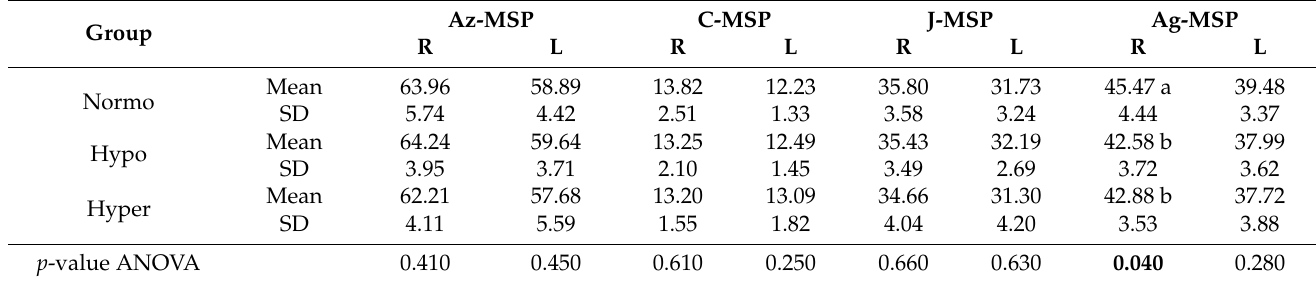
Table 6. Linear asymmetry variables, reported as means (mm) and Standard Deviations (SD) in the three study groups (Normo: Normodivergent; Hypo: Hypodivergent; Hyper: Hyperdivergent). Statistically significant p -values are reported in bold. Different letters indicate statistically significant difference between groups in the Tukey Post Hoc